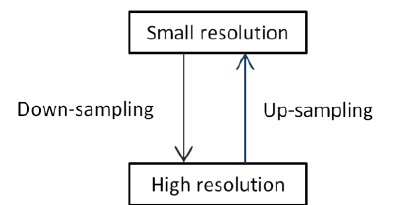
Figure 15. Resampling technique enables raster to exchange their pixel resolution.